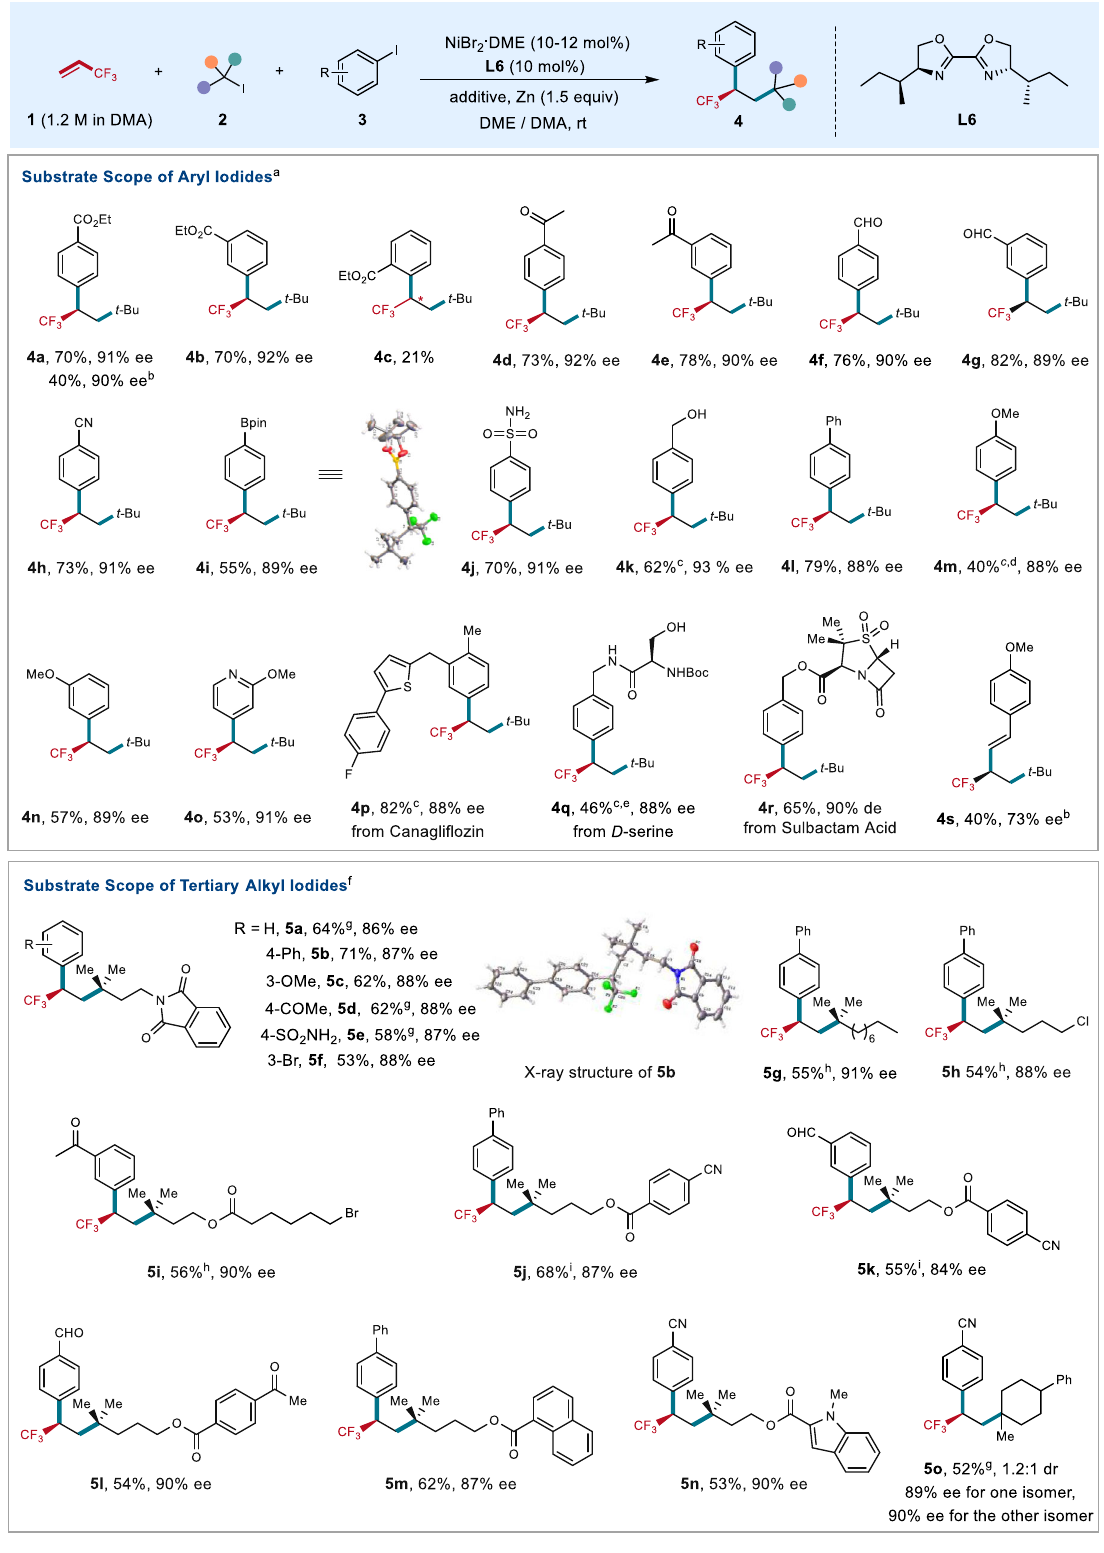
Fig. 2 | Scope of the nickel-catalyzed enantioselective alkyl-arylation of TFP. a Conditions A (unless otherwise speci fi ed): NiBr 2 ·DME (10mol%), L6 (10mol%), 1 (1.2M in DMA, 1.6 equiv), 2 (1.5 equiv), 3 (0.4mmol, 1.0 equiv), DME (3.2mL). All reported yields are isolated yields. b Aryl bromide or vinyl bromide was used. c 0.5 equivofNaIwasused. d 10mol%DMAP, 2 (0.4mmol,1.0equiv)and 3 (0.6mmol,1.5 equiv) were used. e NiBr 2 ·DME (13mol%) and L6 (13mol%) were used. f Conditions